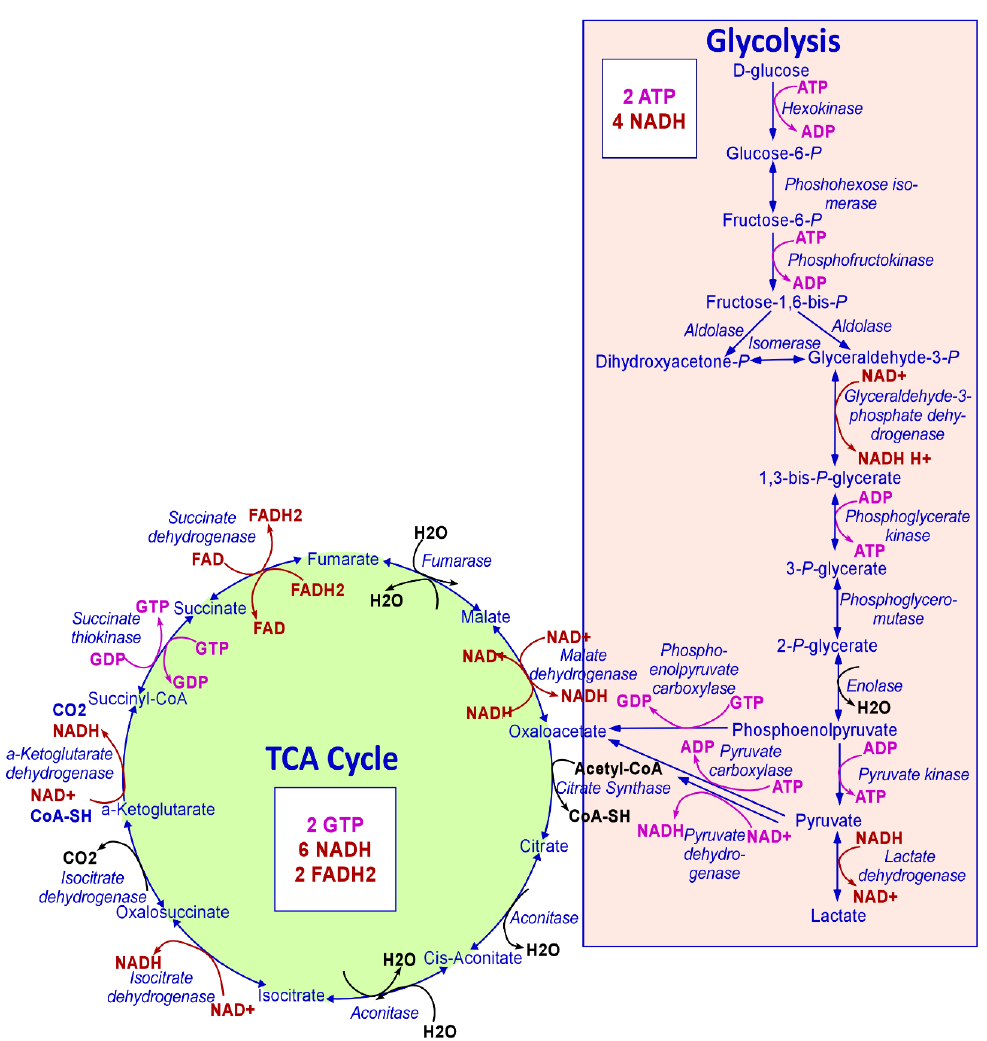
Figure 1. The metabolic steps of glycolysis and TCA cycle. Every step of glycolysis and the TCA cycle are shown. The NAD +/ NADH and FAD / FADH2 generated or utilized are shown in red. The ATP / GTP synthesized and consumed is shown in pink. The numbers of ATP, GTP, NADH, and FADH2 generated when one molecule of glucose is consumed following glycolysis, and the TCA cycle are also